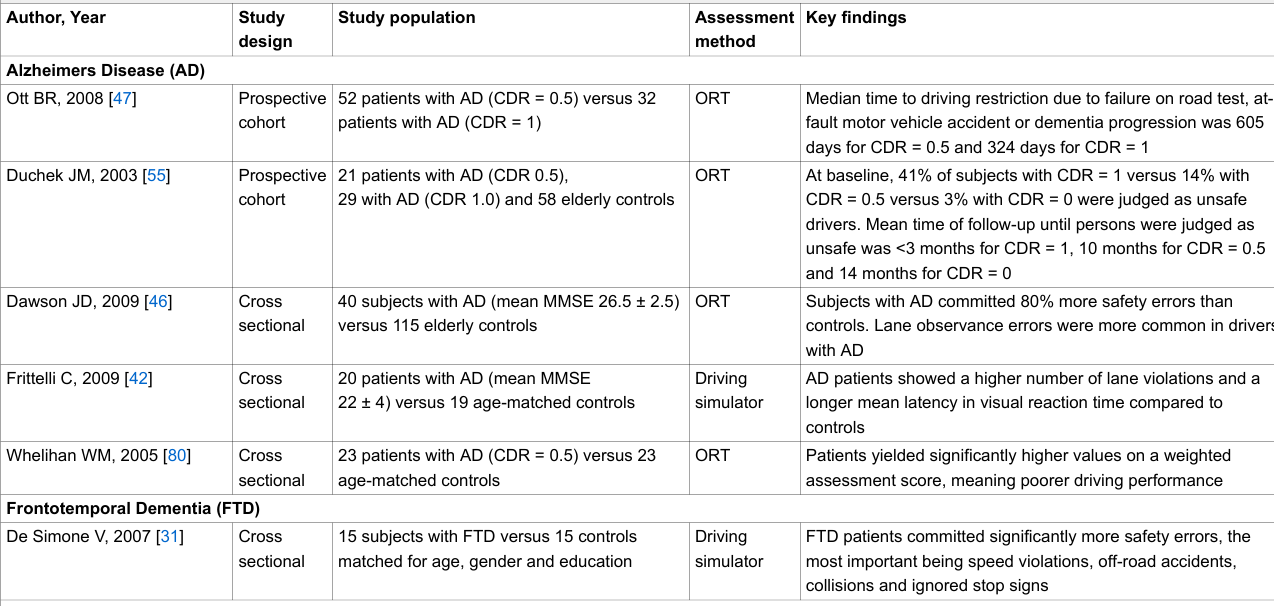
Table 1: Summary of recent studies on dementia and driving